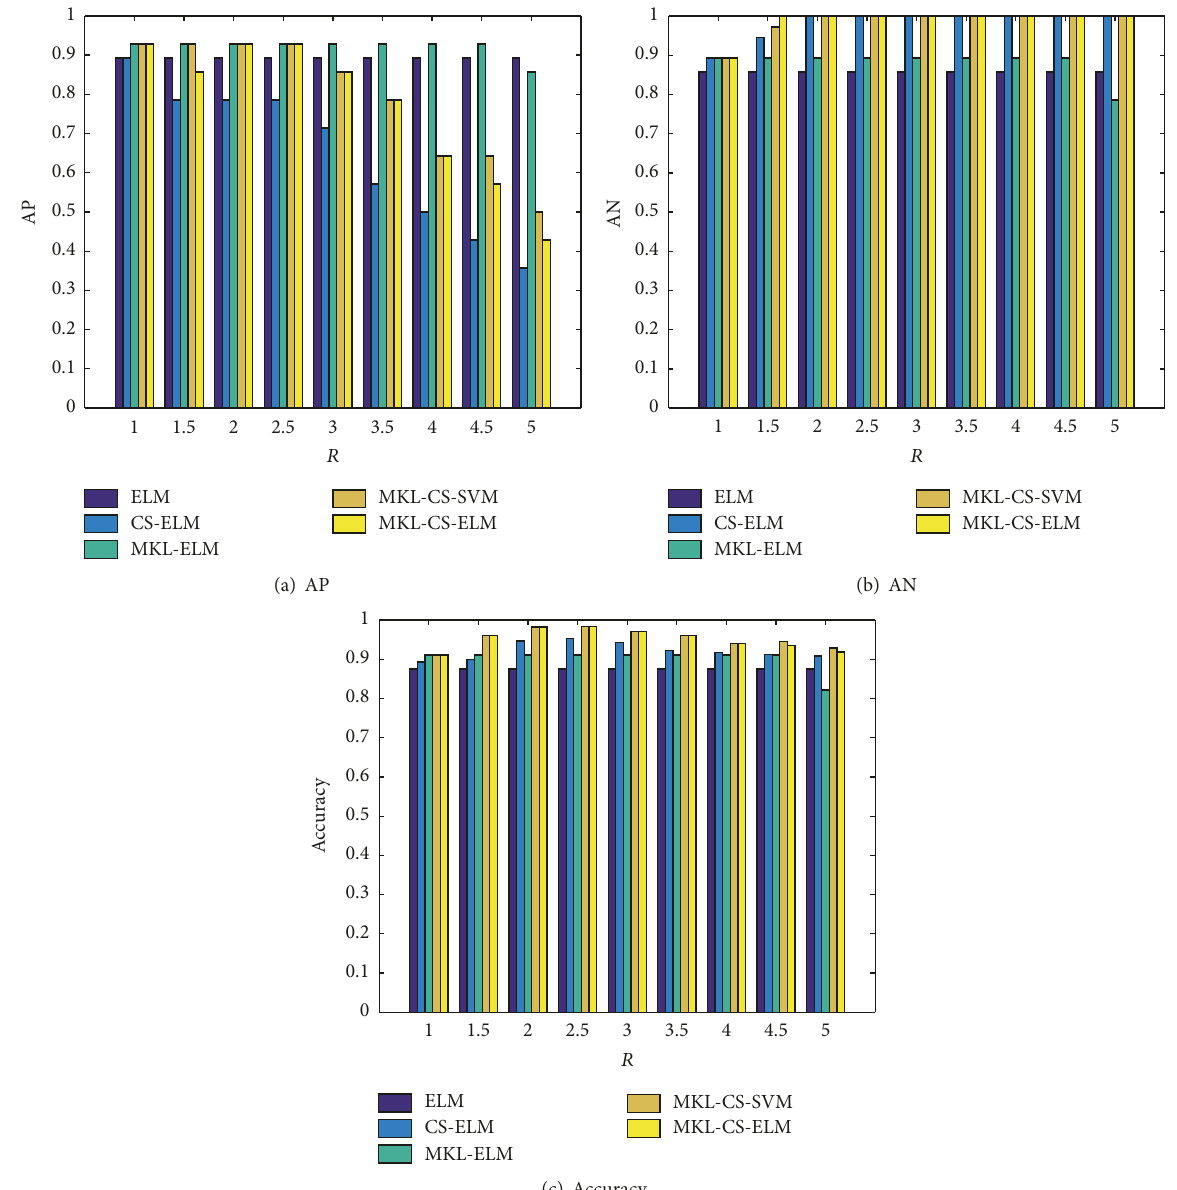
Figure 9: The recognition results of five classification models in